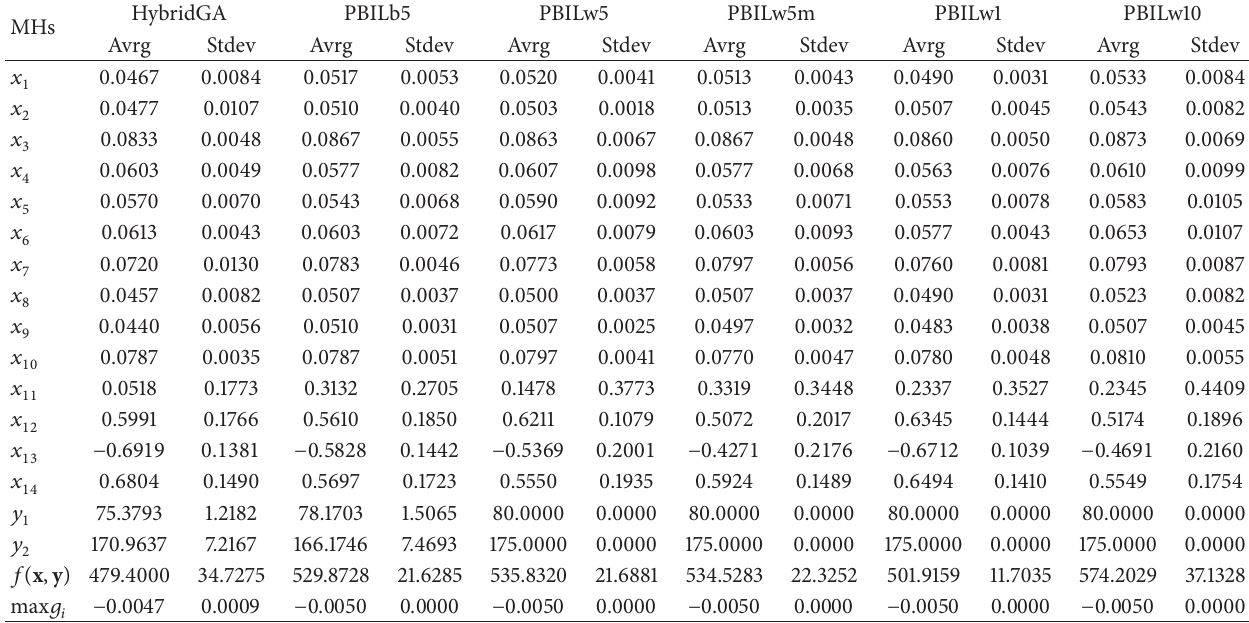
Table 4: Optimum results of